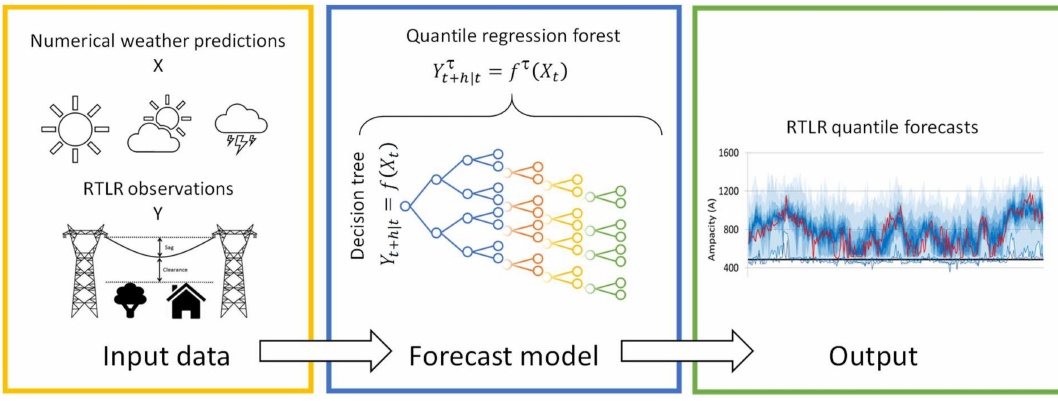
Figure 1. Visual representation of the QRF forecast